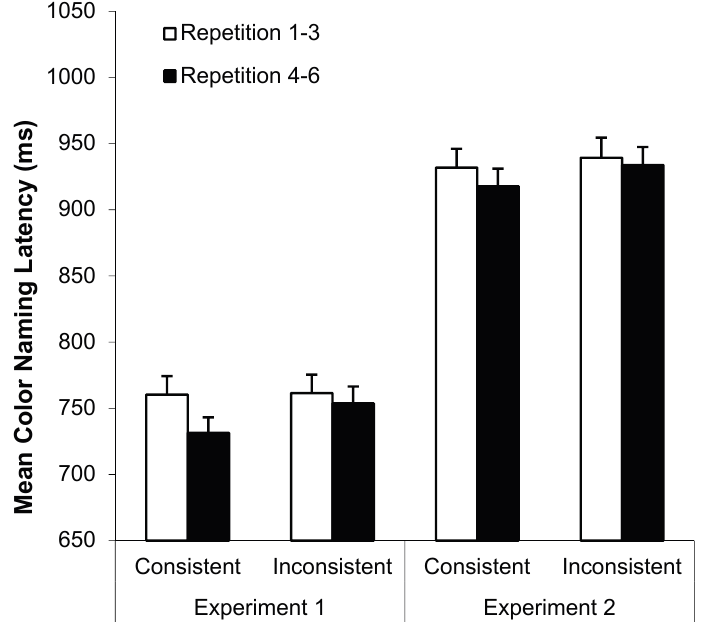
Figure 5. Mean color-naming RTs (+ SE ) as a function of consistency and repetitions 1–3 vs. 4–6 in Experiments 1 (left panel) vs. 2 (right